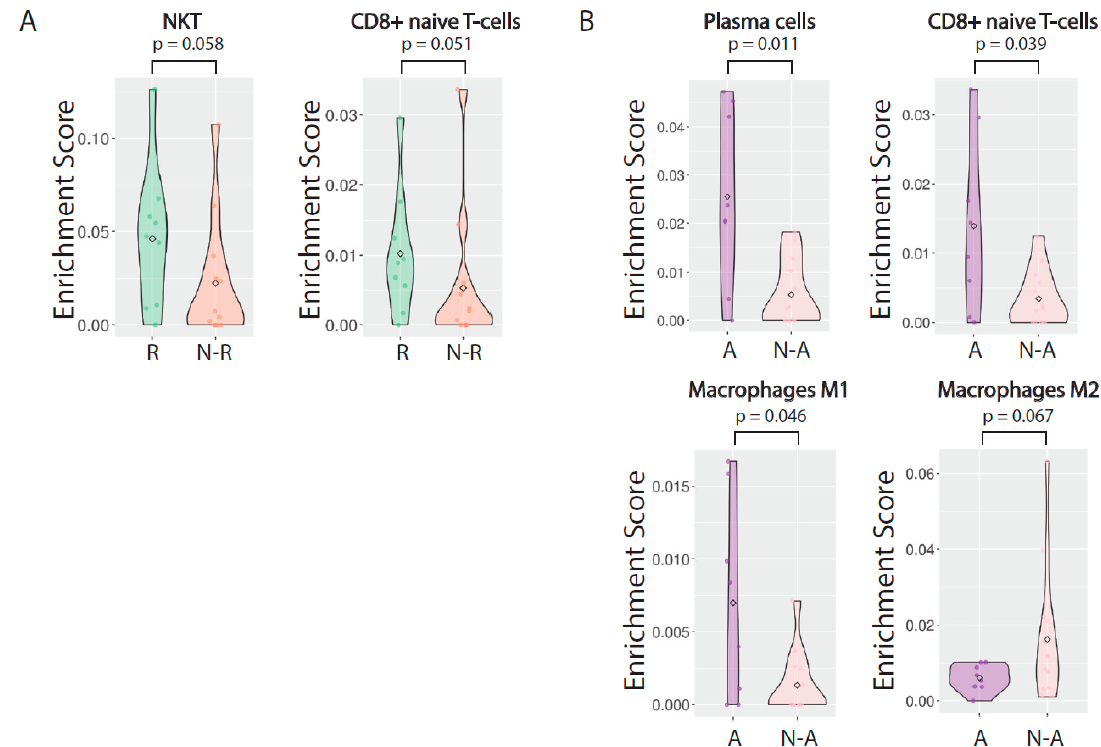
Figure 3. Assessment of the immune microenvironment associated with CRT response ( n = 9 responders, n = 12 non- responders) and aspirin use ( n = 8 aspirin users, n = 13 non-users). ( A ) Cell type enrichment analysis was performed on bulk expression profiles by xCell. Candidate immune populations showing significant (Wilcoxon rank sum test, p < 0.1) differences between CRT responders and non-responders and ( B ) between aspirin users and non-users are shown.